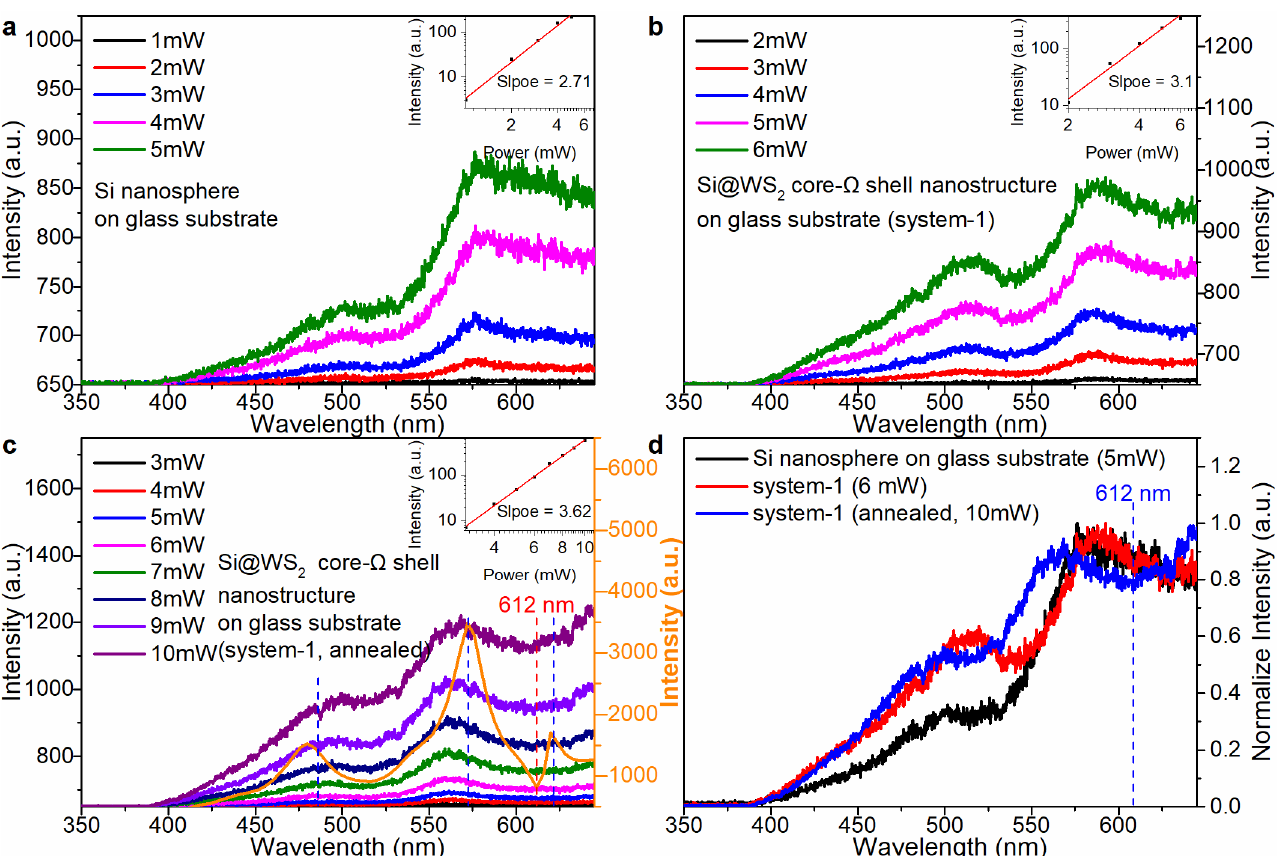
Figure 4. The dependence of luminescence on the excitation pulse power at three different stages. ( a ) The Si NS on glass substrate, excitation wavelength-777 nm. ( b ) The system-1, excitation wavelength-783 nm. ( c ) The system-1 (annealed) with d ~ 190 nm, excitation wavelength-773 nm; the simulated enhancement factor curve of system-1 (orange line) was calculated using FEA method. ( d ) Normalized luminescence comparison diagram at three different stages.